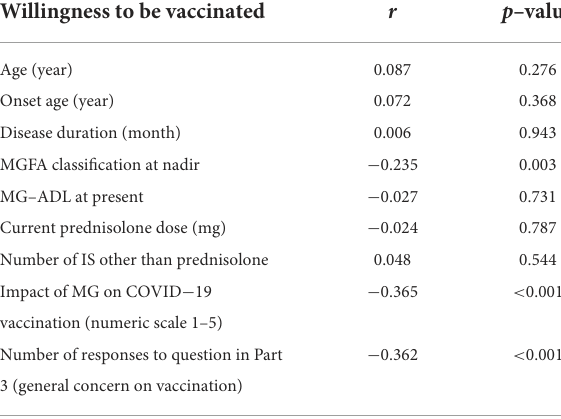
TABLE 3 Correlation between the degree of willingness to get vaccinated and other clinical variables. Willingness to be vaccinated